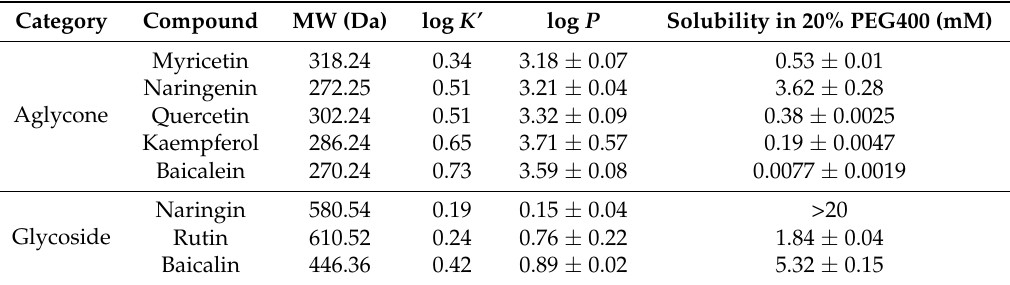
Table 1. Physicochemical properties of aglycone and glycoside